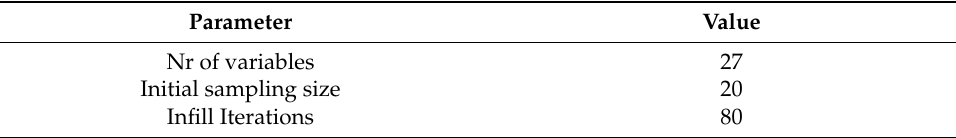
Table 3. SBO framework